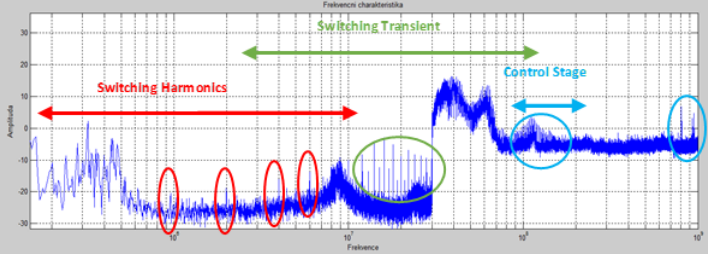
Figure 19. Measurements of power electronics effects as a function of the frequency range of power electronics.